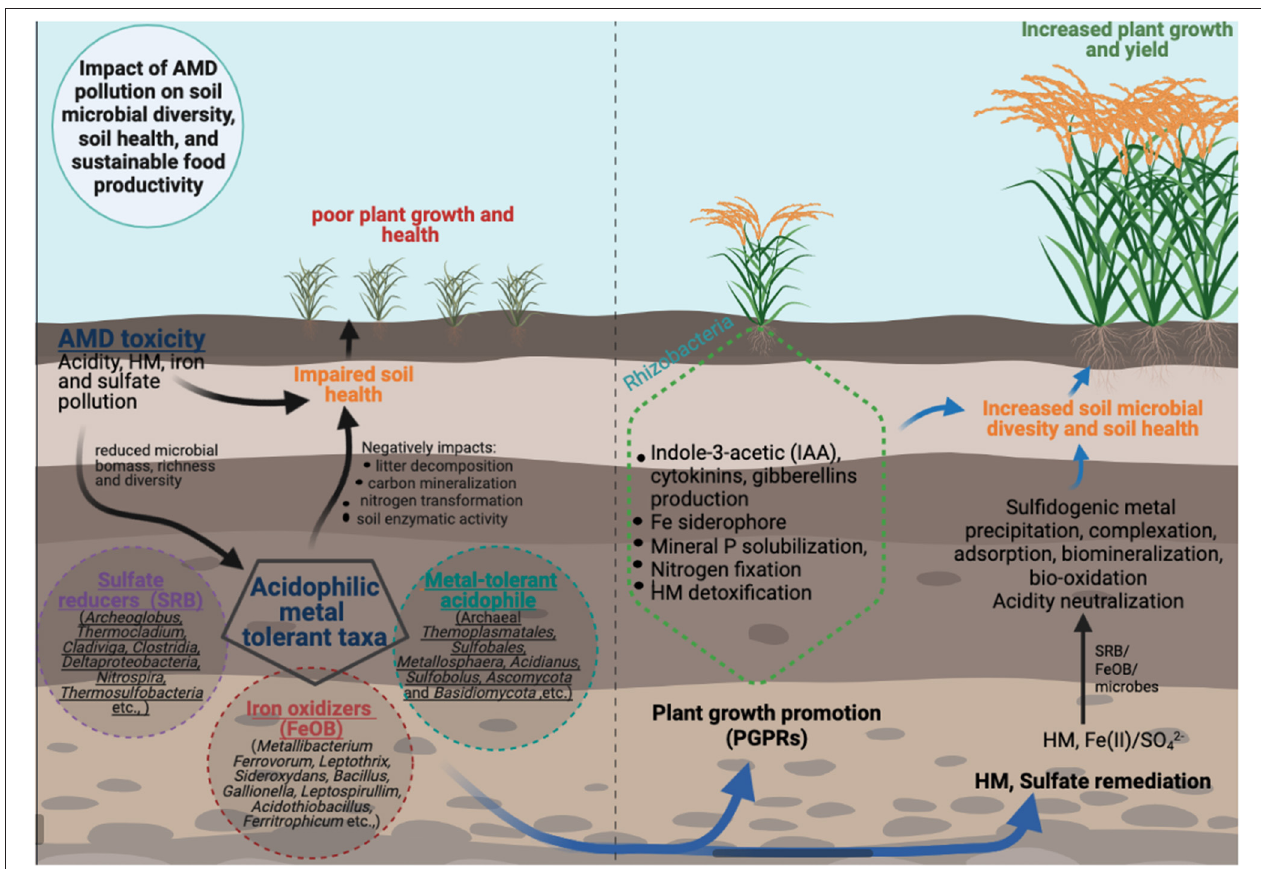
FIGURE 1 | Long term effects of AMD pollution on agricultural soil health, microbial diversity/functions, and plant growth productivity. The potential beneficial functions/applications of adapted autochthonous microbial taxa in improving AMD-impacted soils health and microbial diversity for sustainable agricultural production systems is also illustrated (SRB,sulfate reducing bacteria; FeOB, iron oxidizing